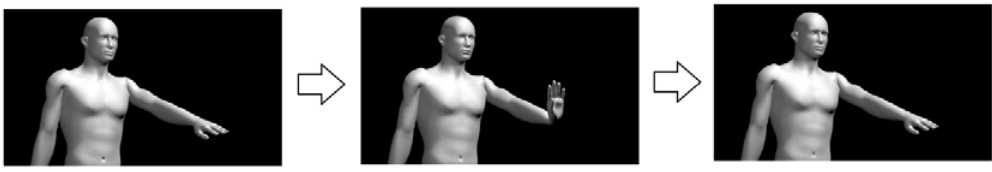
Figure 6. Static representation of a simple movement: wrist extension